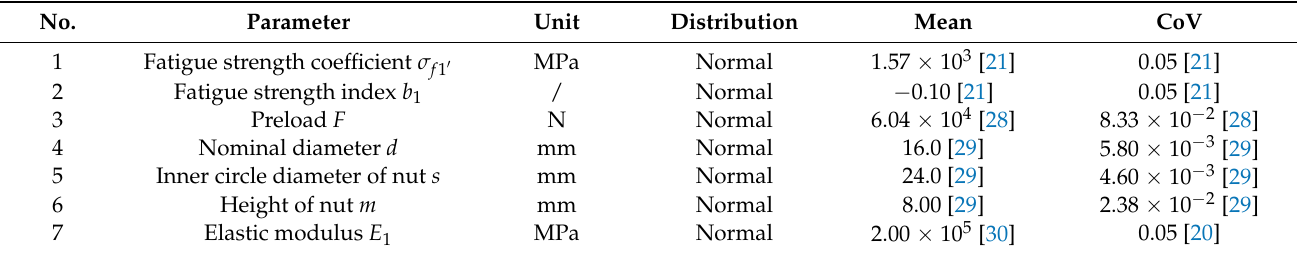
Table 2. Statistical information of the design parameters of the sealing bolt.